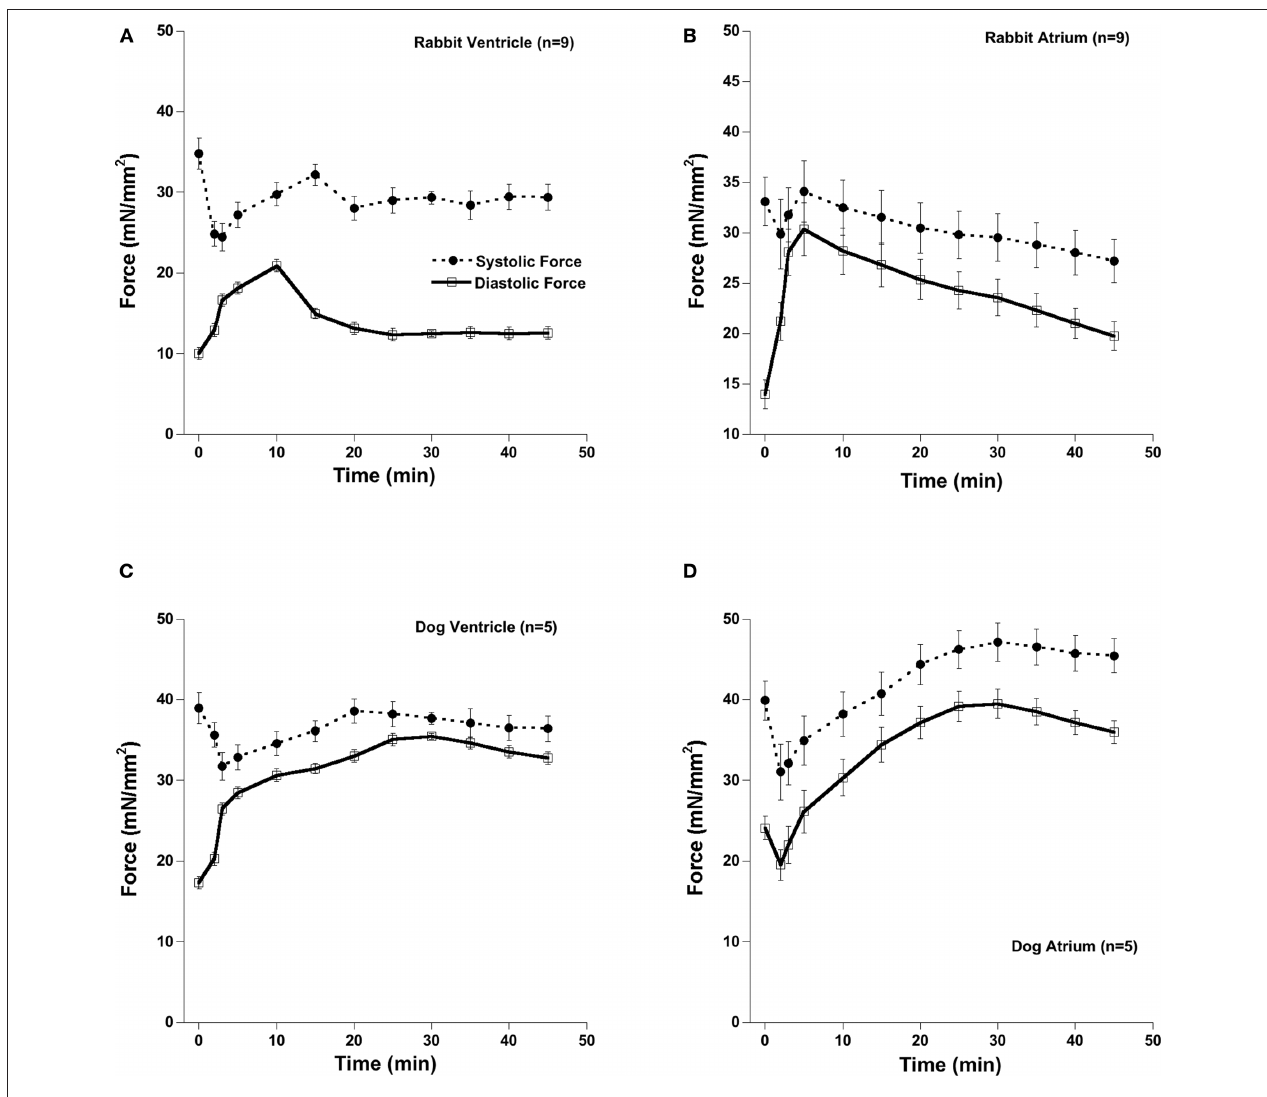
FiguRe 1 | Atrial and ventricular muscles from rabbit and dog developed a rigor like contracture after the exposure of OH*. After the acute OH* exposure there is significant increase in diastolic force and systolic force. After 45 min, there was still significant elevated diastolic and depressed